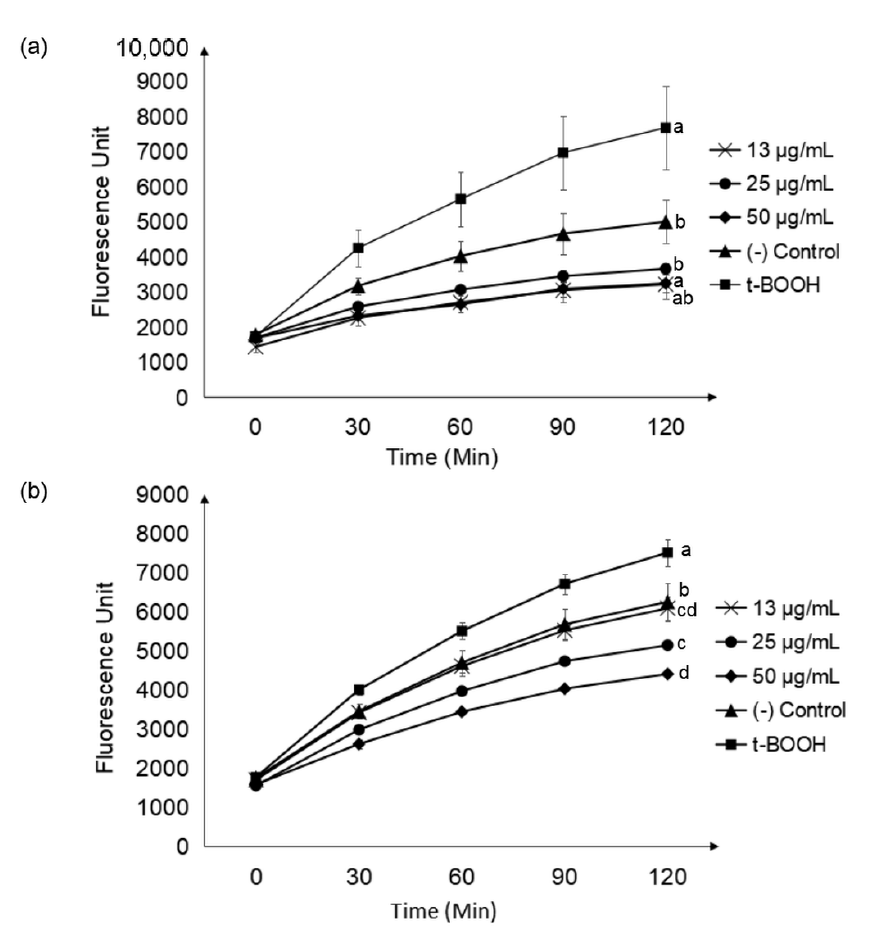
Figure 4. Reduction of innate ROS level after treatment with CNL ( a ) and CNS ( b ) in HepG2 liver cells at various concentrations. ROS production was monitored for 2 h using DCFH-DA assay. All measurements were performed in triplicate and are expressed as mean ± standard deviation. One-way ANOVA was used to compare the variance between different concentrations of samples at 120 min. Means with a common alphabet are significantly similar at p < 0.05. (CNL: Clinacanthus nutans leaf extract; CNS: Clinacanthus nutans stem extract). Table 2. Reduction of ROS level (%) in oxidative stress-induced HepG2 cells after pre-treatment with CNL and CNS as compared to untreated controls using DCFH-DA